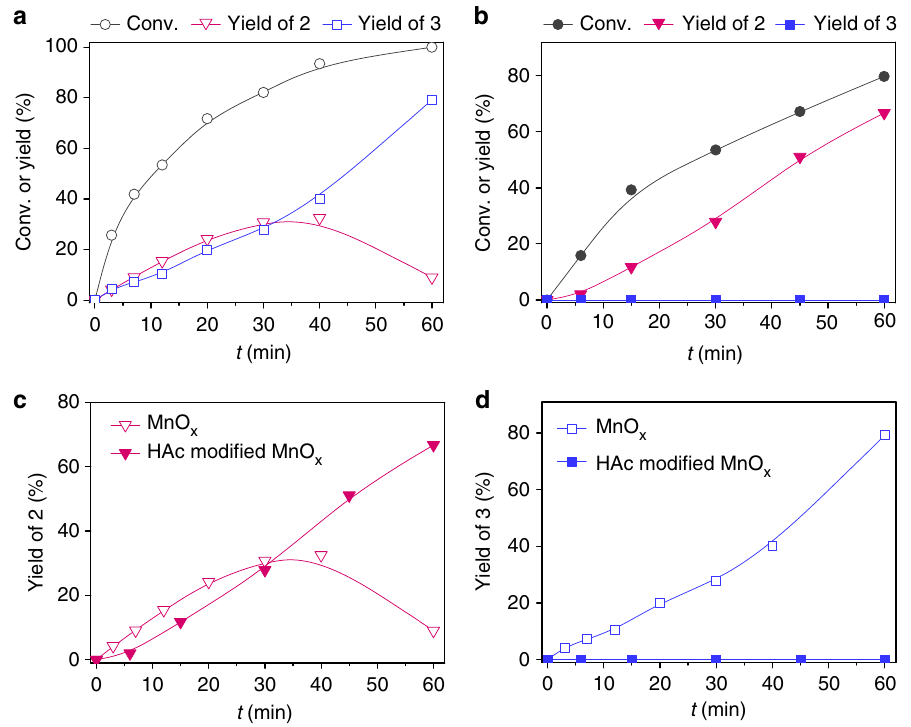
Fig. 7 Time course of the aerobic ammoxidation of 4-hydroxymethylbenzaldehyde. a MnO x as catalyst. b HAc-modi fi ed MnO x as catalyst. c Time course of 2 formation over MnO x and HAc-modi fi ed MnO x , respectively. d Time course of 3 formation over MnO x and HAc-modi fi ed MnO x , respectively. Reaction conditions: 0.5 mmol 4-hydroxymethylbenzaldehyde, 0.17 mmol MnO x , HAc/MnO x = 120 mol% for HAc-modi fi ed MnO x , 5 mL CH 3 CN, 0.3 MPa NH 3 , 0.3